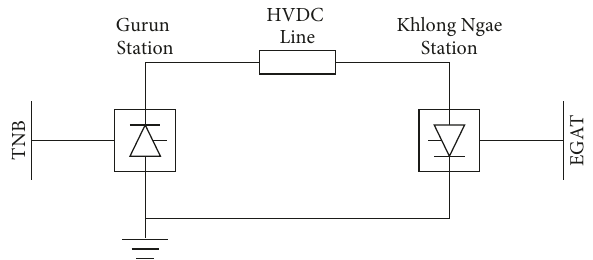
Figure 1: Monopolar HVDC transmission system with a metallic power return path.